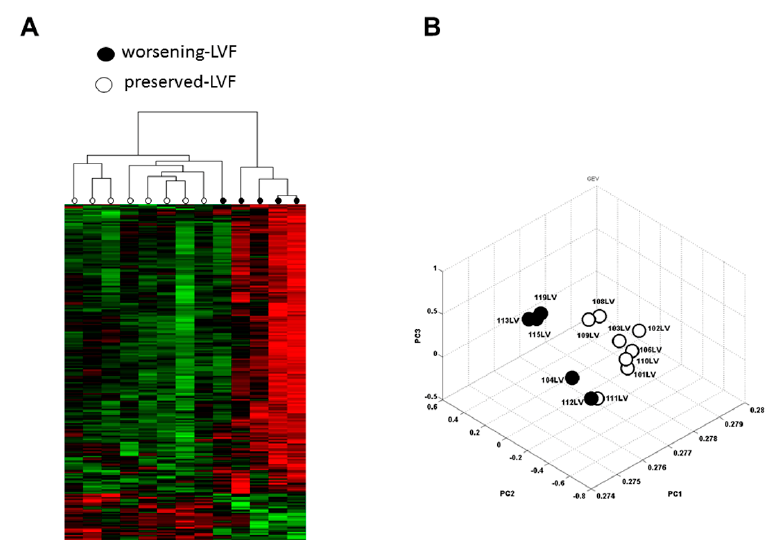
Figure 1. Heatmap and principal component analysis (PCA). ( A ) Unsupervised hierarchical clustering analysis of the gene expression profiles between worsening-LVF and preserved-LVF. Each row represents an individual sample, and each column represents a specific expressed sequence tag (EST). Bar color indicates gene mRNA expression level. The rows (13) of colored bars (718) represent the significant genes altered by more than 25%, between five worsening-LVF patients and eight preserved-LVF patients. The scale bar represents the intensity of expression (green: low expression, black: medium expression, and red: strong expression). The dendrogram on the top depicts the relationship between individuals. The dendrogram scale was calculated via the distance method (i.e., line length is inversely proportional to relatedness). ( B ) The PCA plot demonstrates the quality of the array. Each dot represents an expression pro fi le of an individual sample plo tt ed by the PCA score. ● = worsening-LVF; 〇 = preserved-LVF.